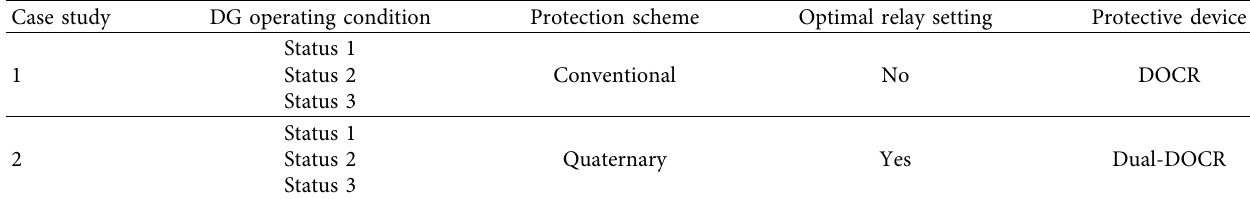
Table 3: Classification of the comparative case studies.